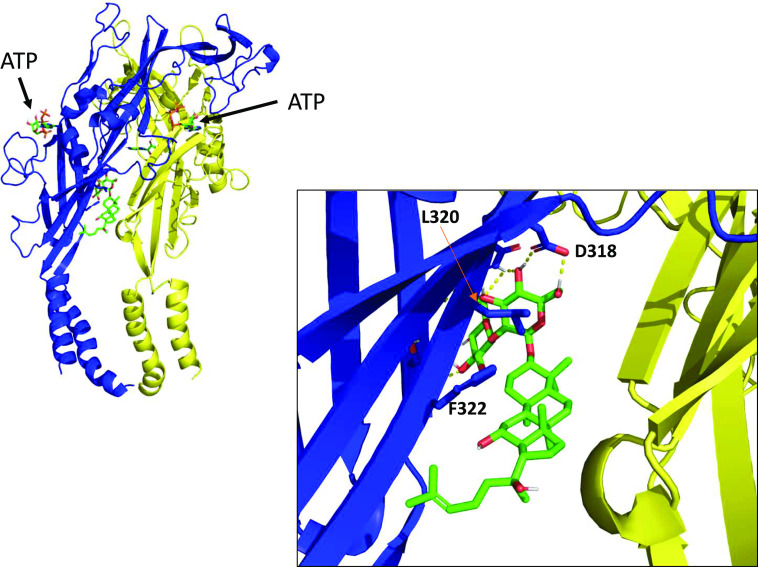
Induced-fit docking of 20S-Rg3 at human P2X7 ginsenoside-20(S)-Rg3 (green) docked into the central vestibule site in a homology model of ATP-bound human P2X7 (open state). The predicted orientation of the stereocentre C-20 is such that the –OH is pointing away from the hydrophobic face of the binding site, thus minimizing any repulsive interactions. Key side chains of residues D318, L320, and F322 are indicated.